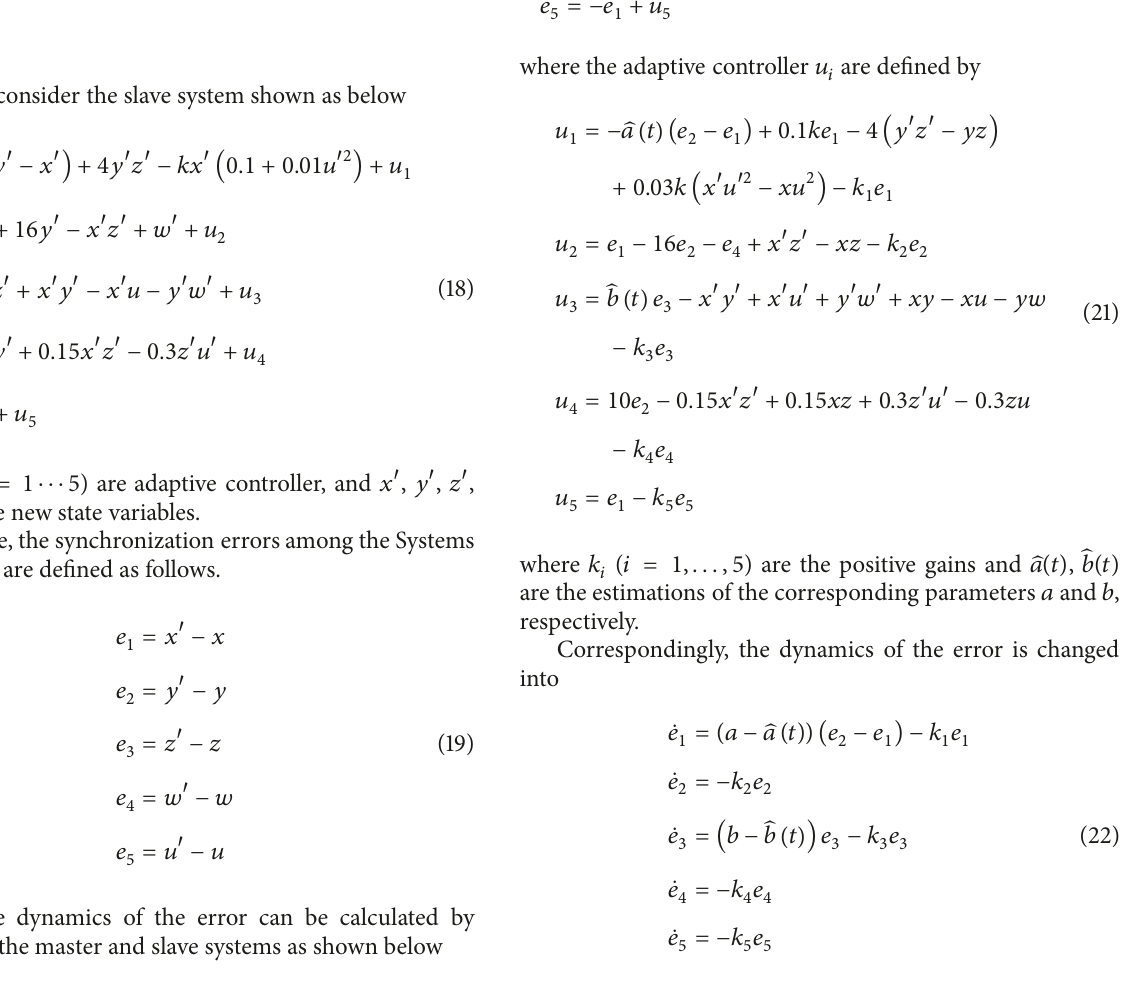
Figure 4: The relationship between 𝑥 and 𝑊(𝑥) for the circuit as shown in Figure